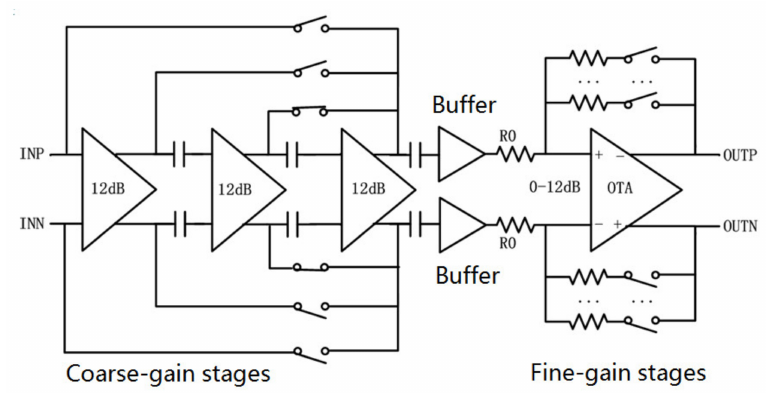
Figure 6. The topology of the programmable gain amplifier.